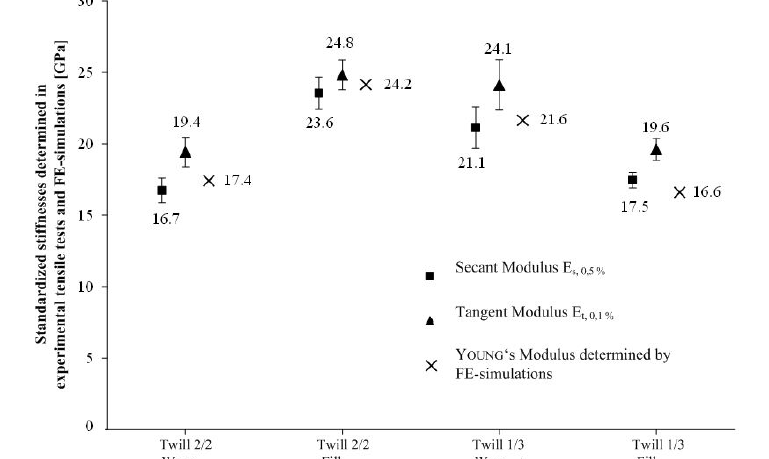
Figure 9: Secant modulus and tangent modulus of the respective textile semi-finished products based on the experimentally determined values of the fibre volume content of φ f .